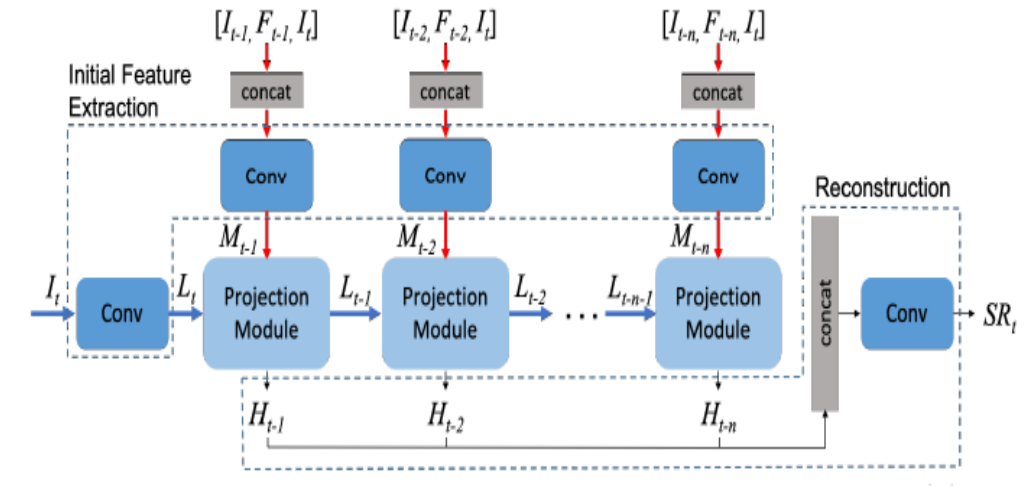
Figure 2. Sketch map of RBPN (Haris et al., 2019)